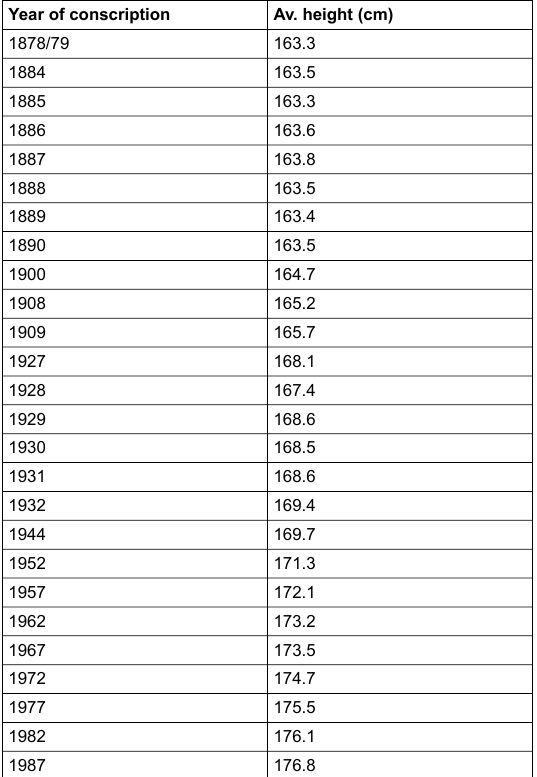
Table 3: Published average heights of Swiss conscripts 1878/